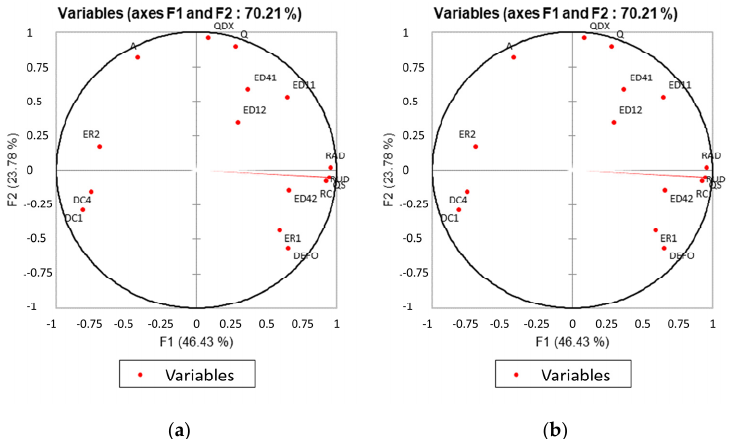
Figure 12. Variables spaces of the PCA (Principal Component Analysis) analysis; ( a ) components 1 and 2; ( b ) components 3 and 4.